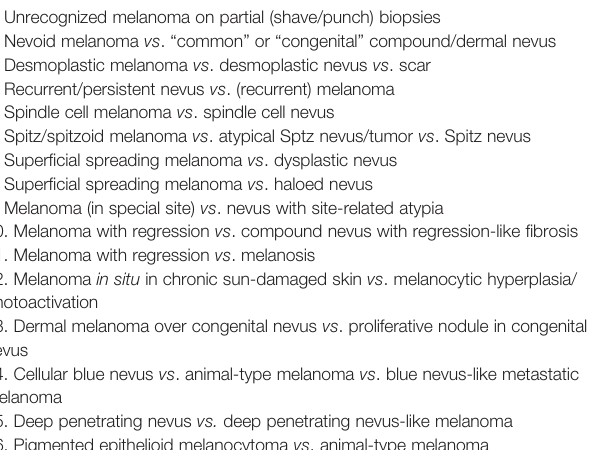
TABLE 1 | Main settings of diagnostic dif fi culties in melanocytic skin